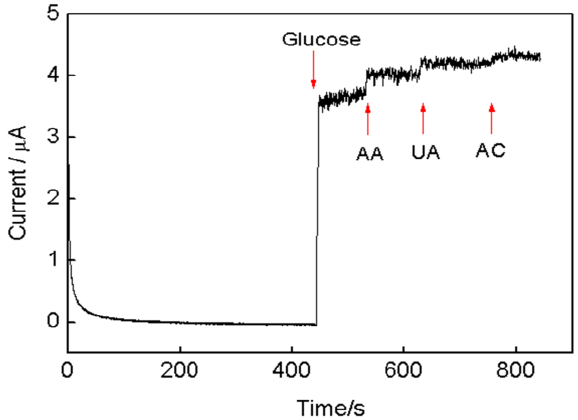
Figure 8. Typical current-time curve recorded at a PPy-RGO-(AuNPs-GOD) 4 /GCE during the addition of glucose, ascorbic acid (AA), uric acid (UA), and acetaminophen (AC) at a potential of 0.5 V versus SCE.